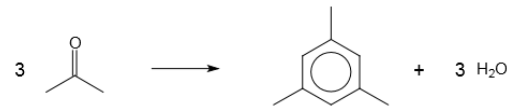
Figure 7. Conversion of carbonyl compounds to aromatic hydrocarbons, illustrated by the reaction of acetone to form mesitylene (1,3,5-trimethylbenzene).